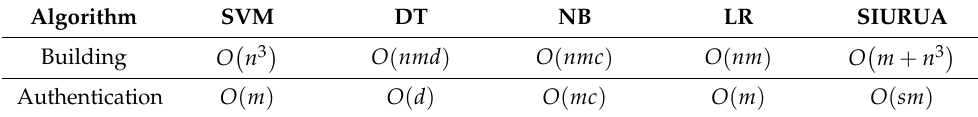
Table 5. Time complexity comparison of machine learning algorithms and SIURUA.